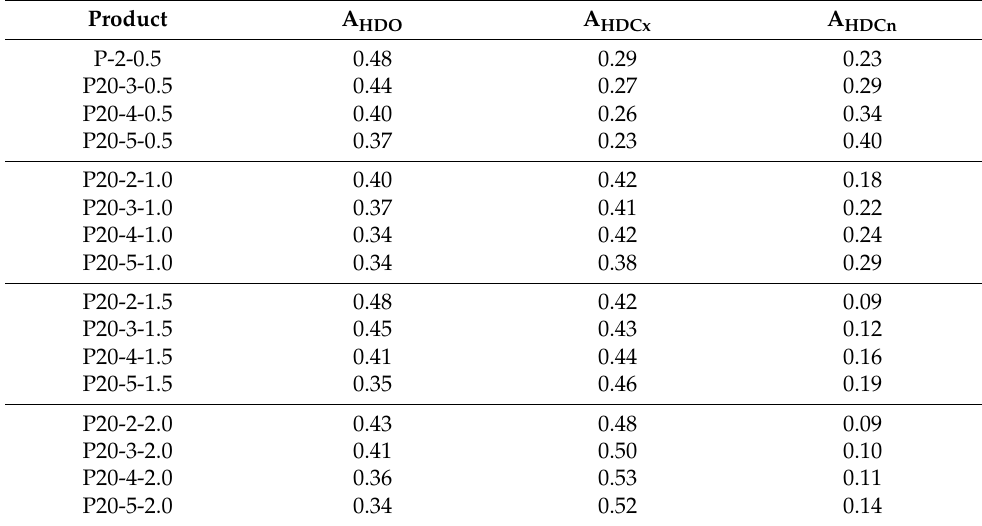
Table 9. The shares of the HDO, HDCx and HDCn reactions in the RO conversion during the hydrotreating of the F20 feedstock.